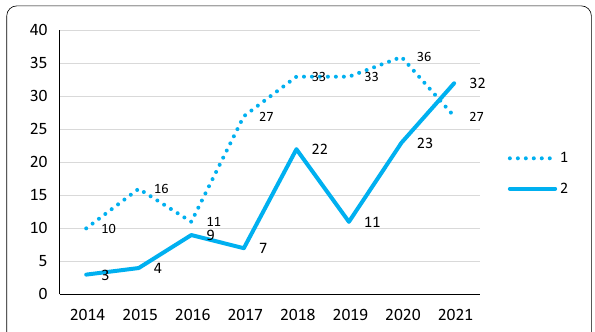
Fig. 2 Number of publications by the corresponding author’s profession and year (Note: 1